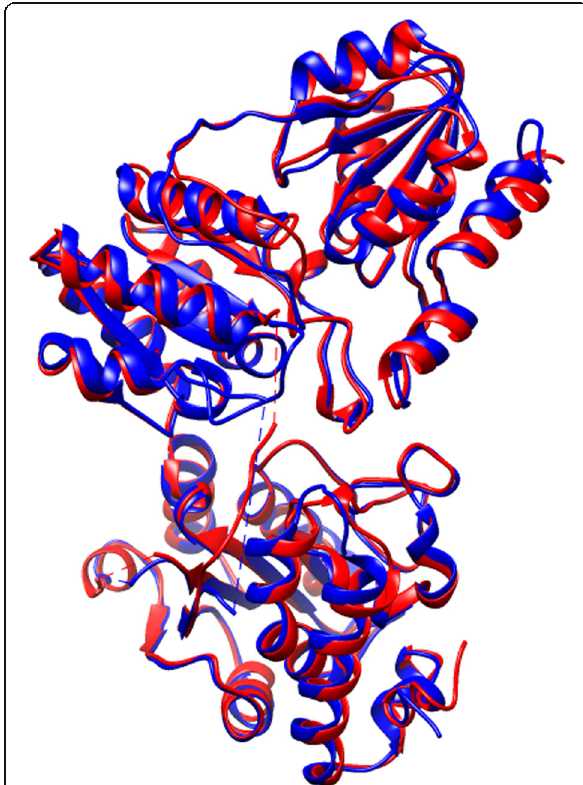
Fig. 2 Structural overlap of DXS structures of Escherichia coli and Deinococcus radiodurans , showing a structural conservation of 468 residues across the secondary structure elements. The structures are superimposed and represented through Chimera 1.14